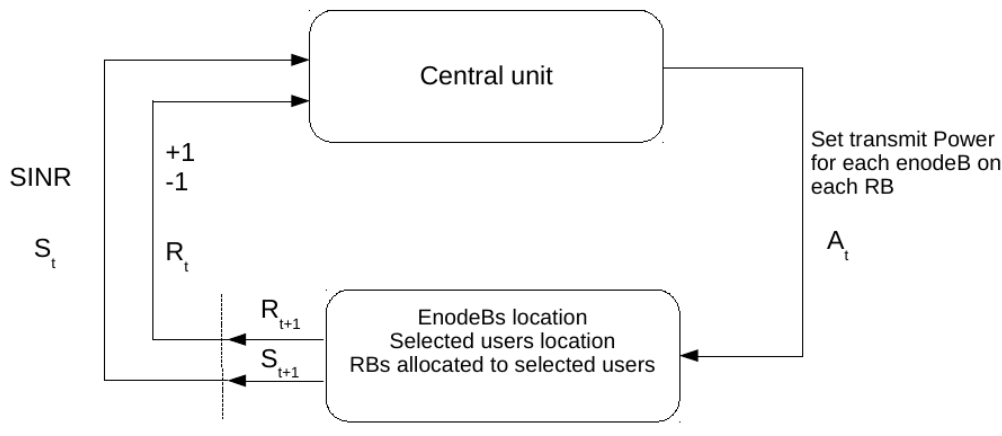
Figure 6. Reinforcement learning agent–environment interaction of the power allocation problem.